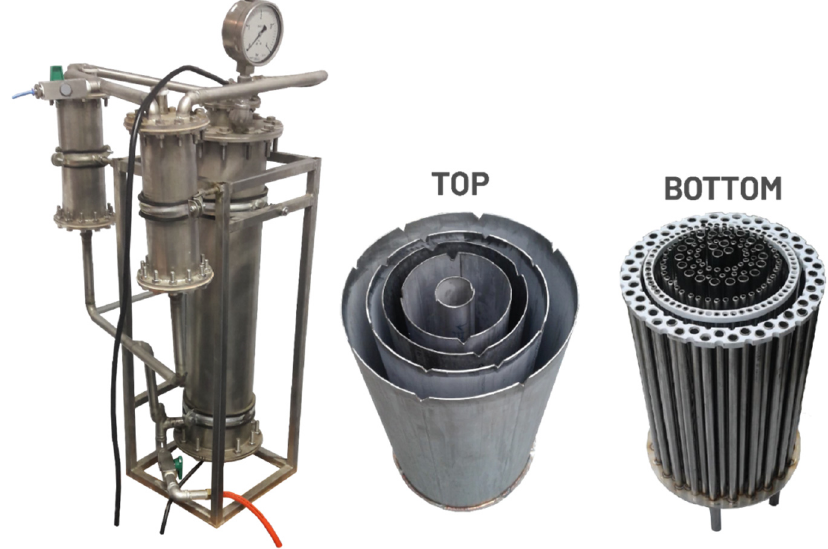
Figure 1. View of the investigated alkaline electrolyzer.